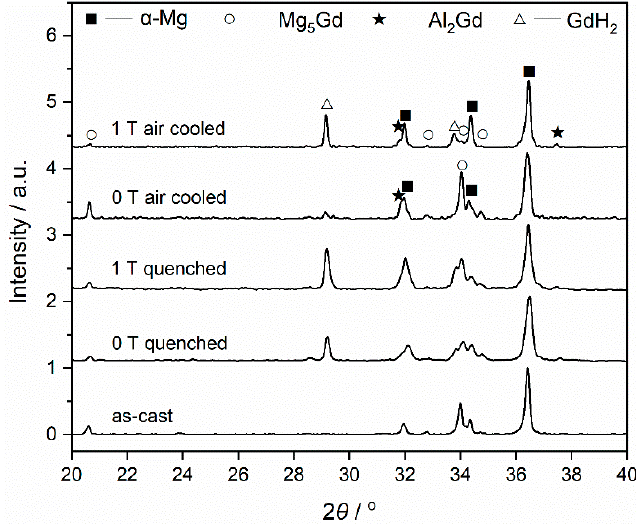
Figure 5. XRD patterns of the as ‐ cast Mg–Al–Gd alloy and those quenched and air cooled under 0 T and 1 T.